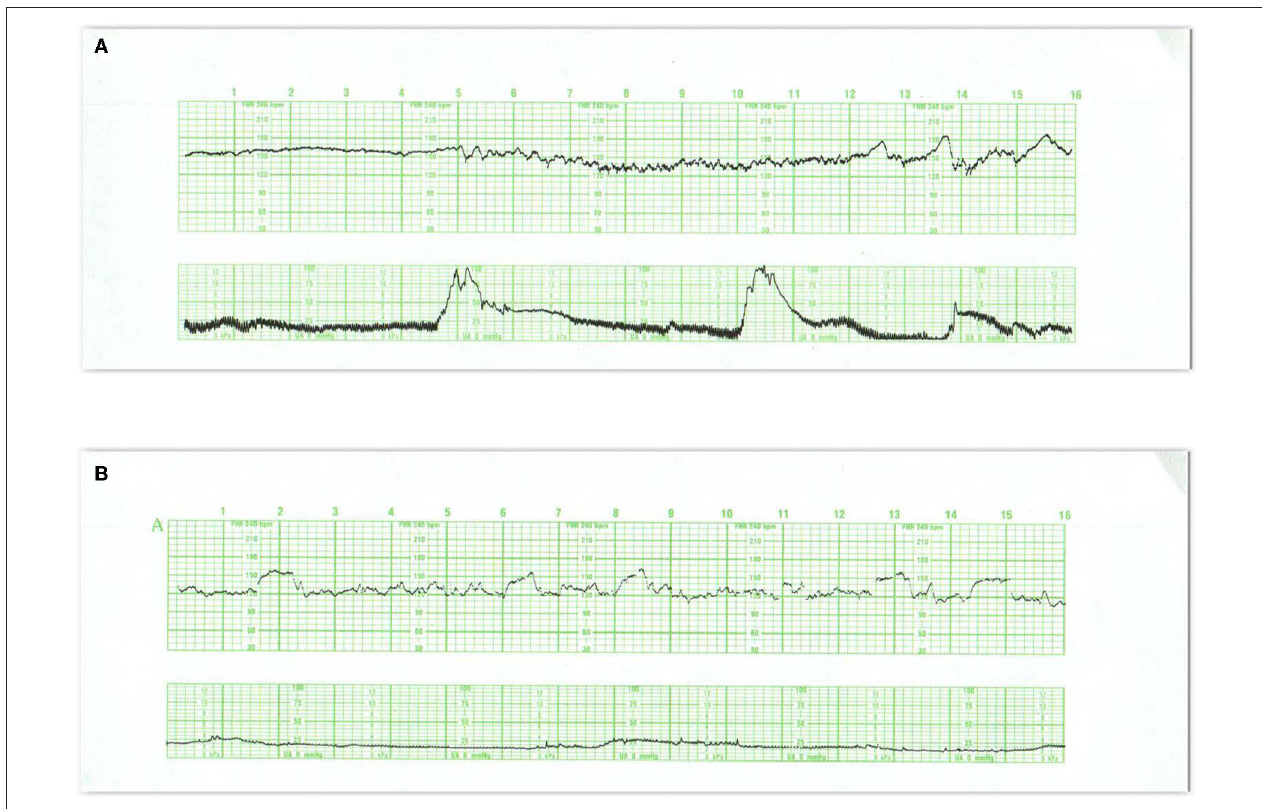
FIGURE 1 | These tracings illustrate state changes in the fetus during early labor. Notice the three distinct FHR patterns in (A) . In the first 5min the pattern is characterized by diminished short- and long-term variability representing quiet sleep. From 5M to 12M, the short- and long-terms variability increases and the rate decreases, likely representing fetal breathing movements, with accelerations. From 12M to 16M the tracing becomes reactive with normal variability, obvious accelerations, and presumable, fetal movement. This is a reassuring tracing and would be no more troublesome if the baseline rate were below 120 or 110 bpm (a baseline bradycardia). (B) Obtained with a direct scalp electrode reveals accelerations during and between contractions. These accelerations are likely associated with fetal movement. Fetal reactivity may persist into early or mid-labor despite the administration of analgesia. Scaling − 30 bpm/cm—vertical, 3 cm/min—horizontal— each panel is 16min